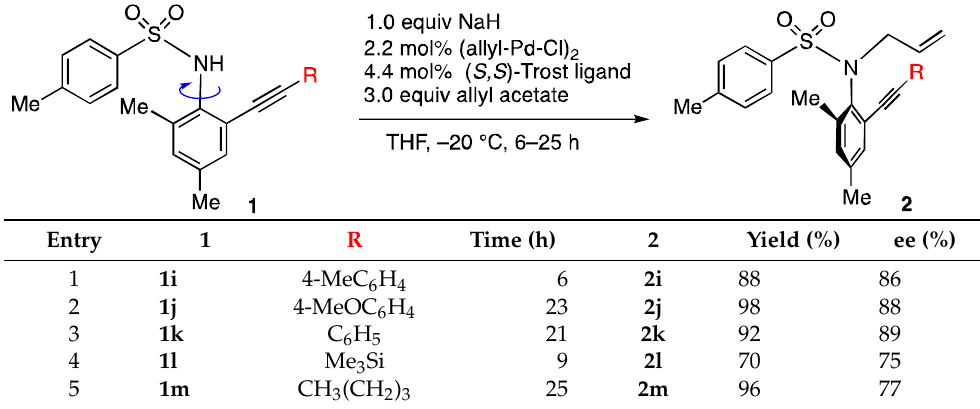
Table 2. Substituent effect on alkynyl group in enantioselective N -allylation.